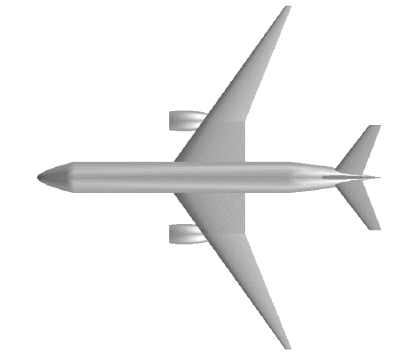
Figure 3: A typical geometrical model of aircraft configuration.